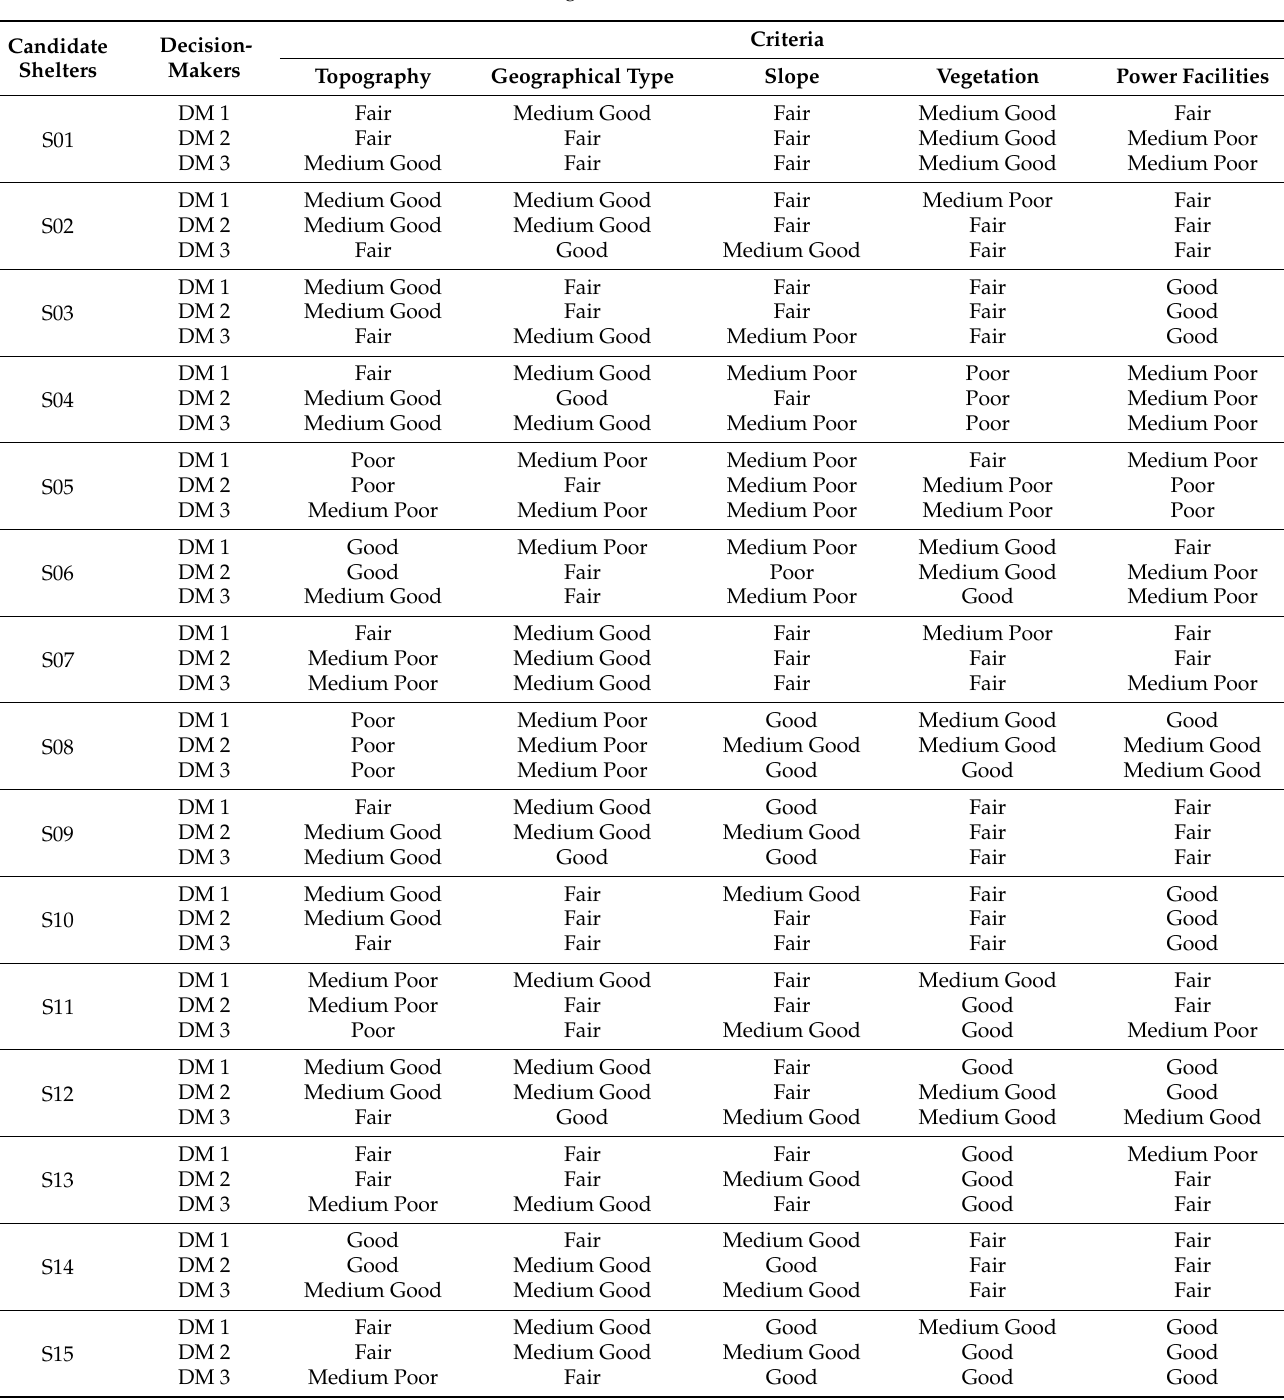
Table 8. The linguistic values of each